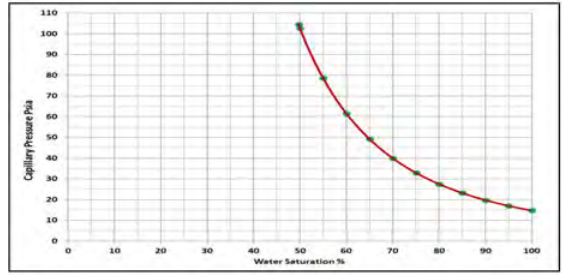
Figure 14. Capillary pressure curve for Upper Bahariya